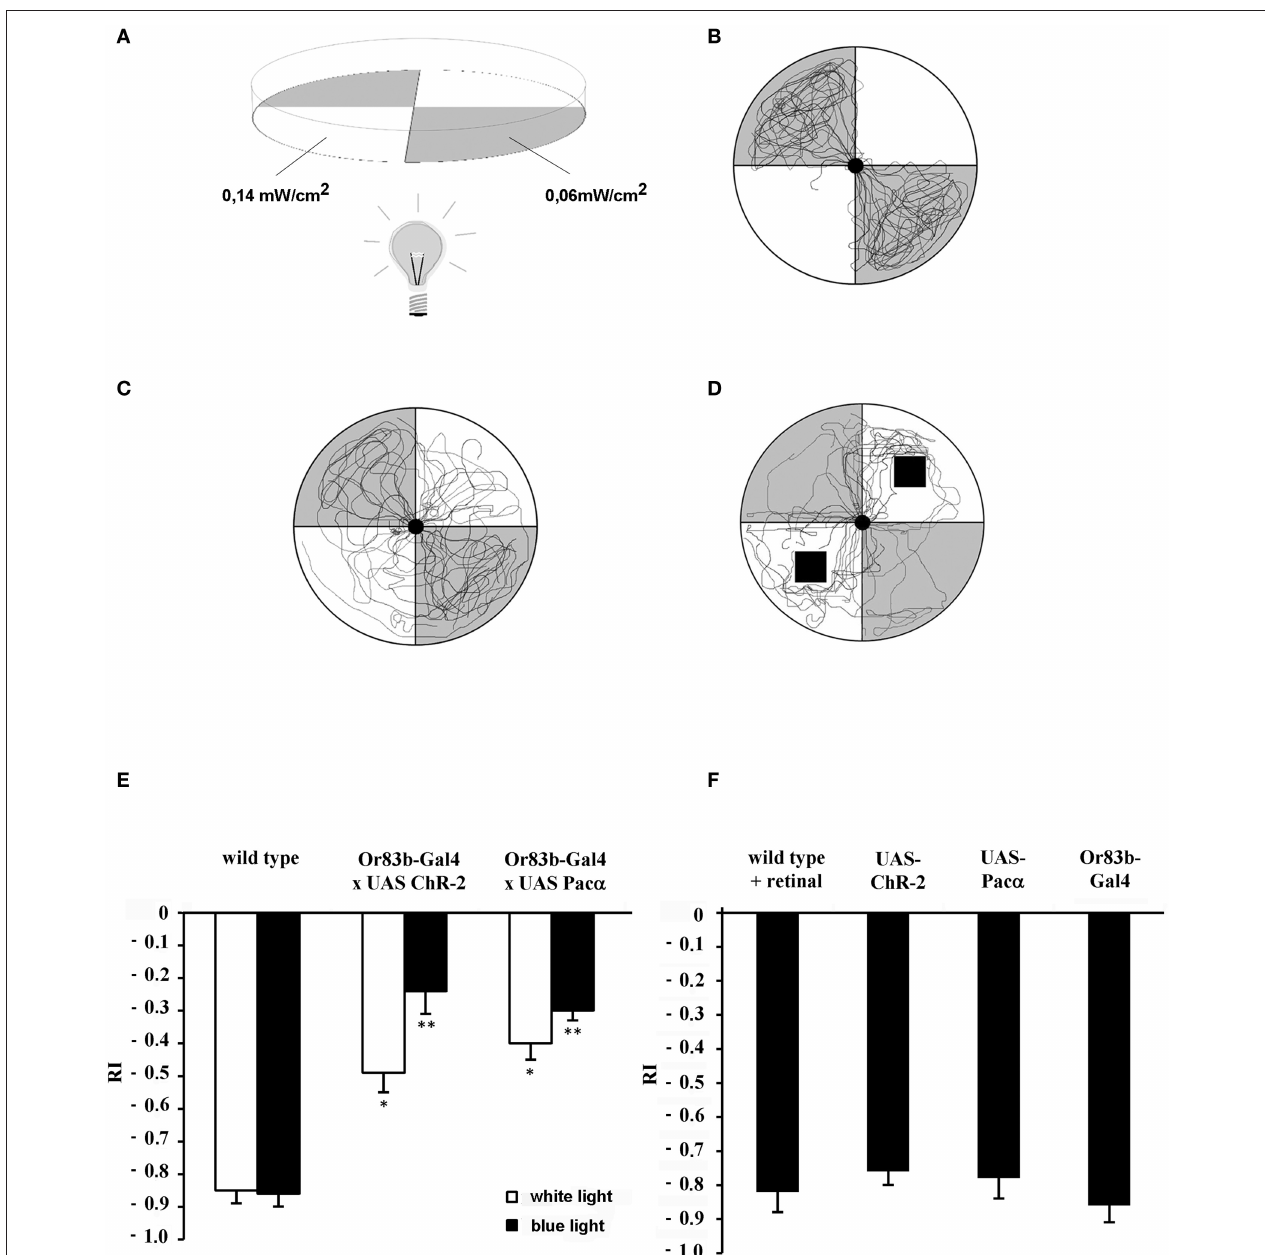
transgenic larvae that express either ChR-2 or Pac α in all ORNs under control of the driver line Or83b-Gal4. *RI values are statistically different from those of wild type larvae ( t -test, P < 0.05); **RI values are statistically different from those of transformed larvae stimulated with white light ( t -test, P < 0.05). Negative phototaxis is strongly reduced in the transgenic strains expressing the light-sensitive proteins in all ORNs. (F) As control strains wild type larvae fed with retinal (wild type + retinal) or parental lines (Or83b-Gal4 and UAS lines) were used ( n = 15 each). Here, a strong light avoidance can be